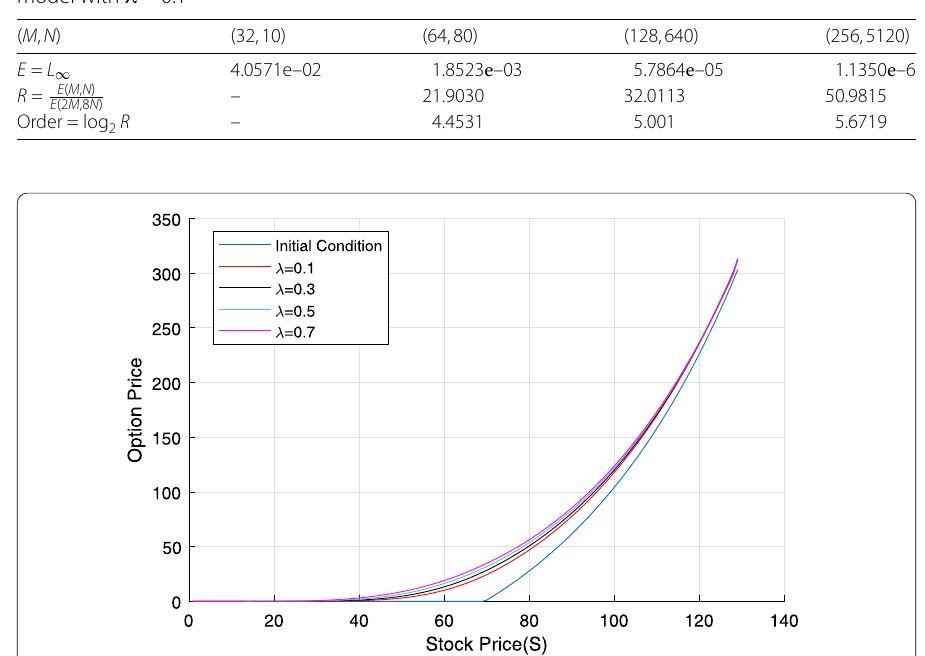
Figure 2 American call option prices versus stock prices. Initial condition and numerical solution under the Merton jump-diffusion model for American call options at various states of economy